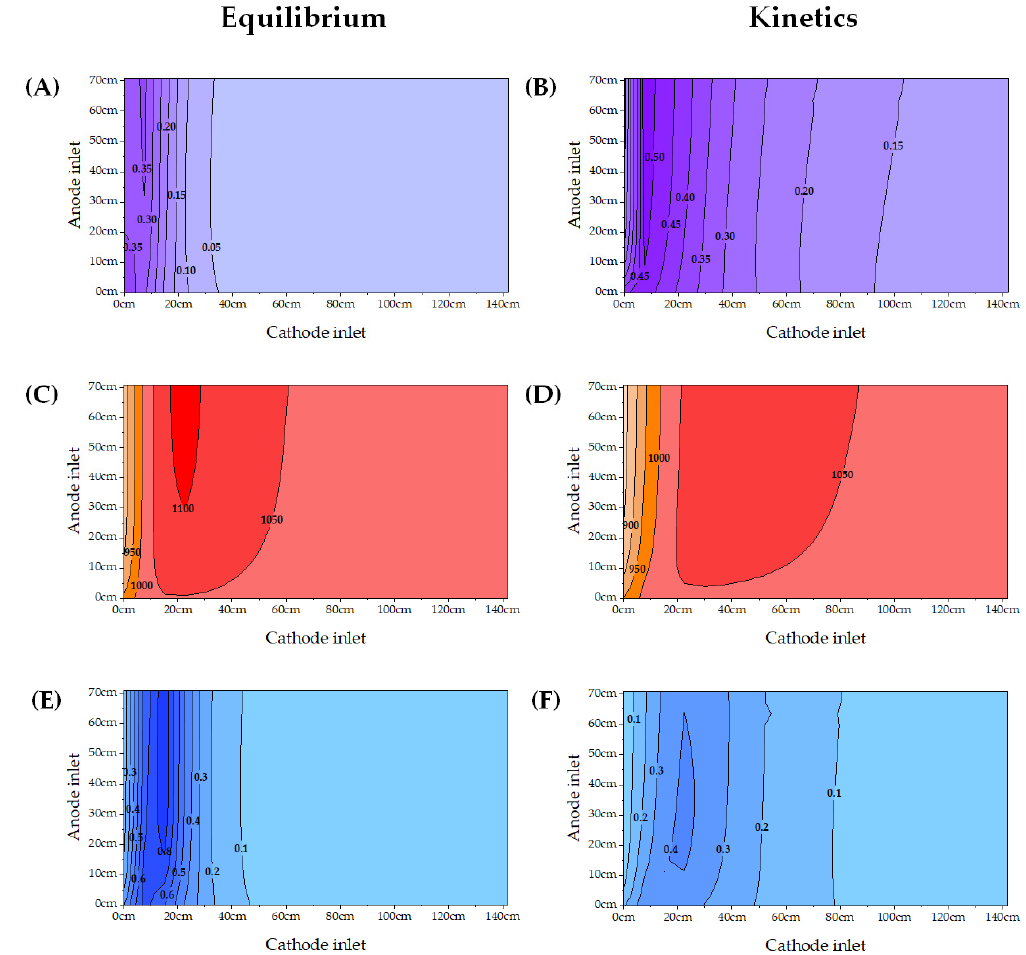
Figure 1. Results of the direct internal reforming (DIR-SOFC) simulation using steam reforming (SR) equilibrium ( A , C , E ) and kinetics formulation ( B , D , F ,); local maps of molar fraction of H 2 ( A , B ), temperature of the solid structure in K ( C , D ) and current density in A cm − 2 ( E , F ). Table 5. Main results of different simulations basing on equilibrium and surface reaction mechanism approaches.